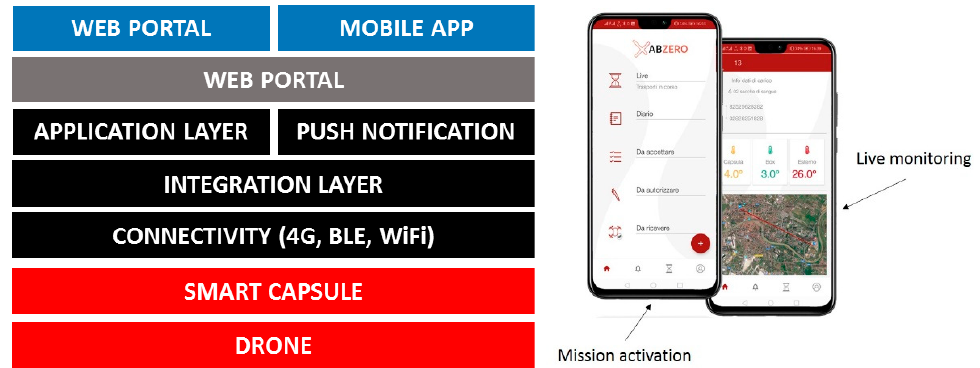
Figure 2. Overall software architecture (Left) and Spoke app (Right).